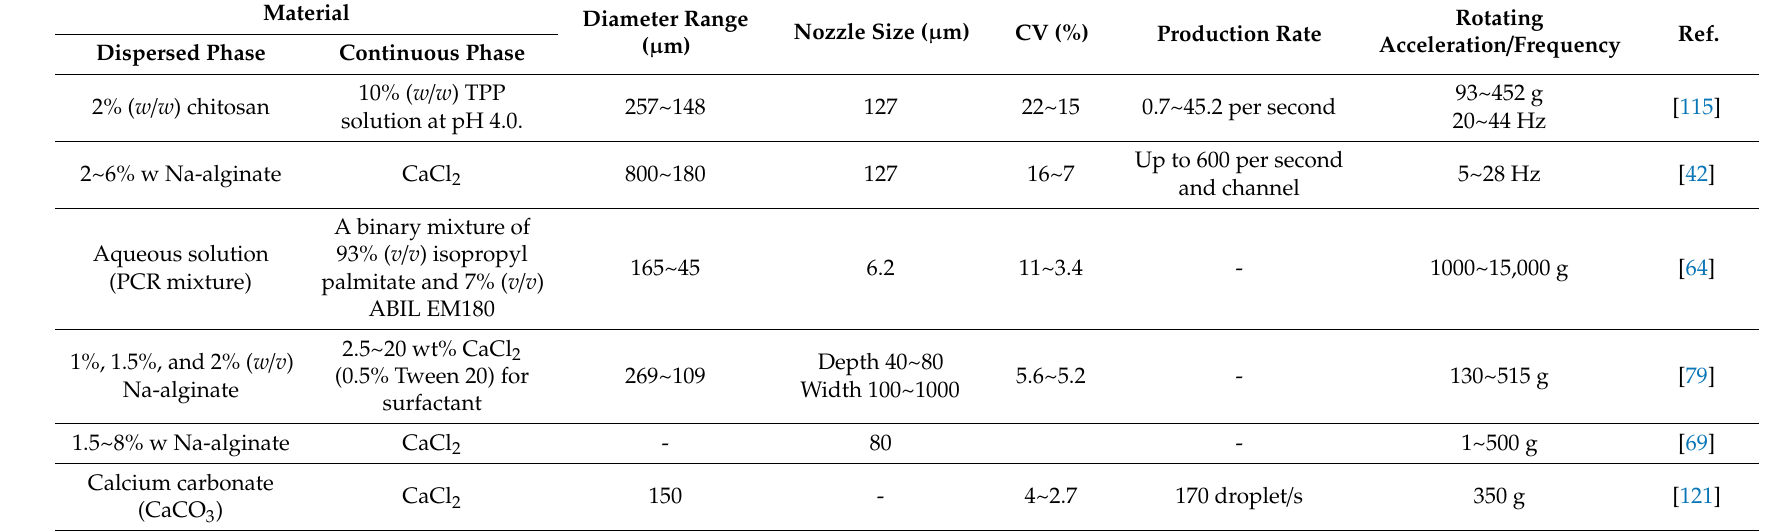
Table 2. Summary of reported dispenser nozzle